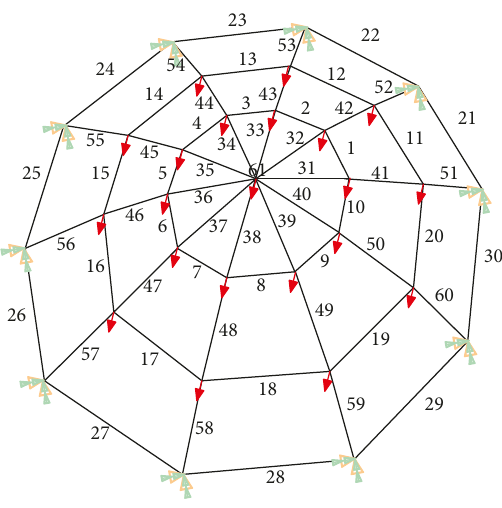
Figure 9: Uniform load